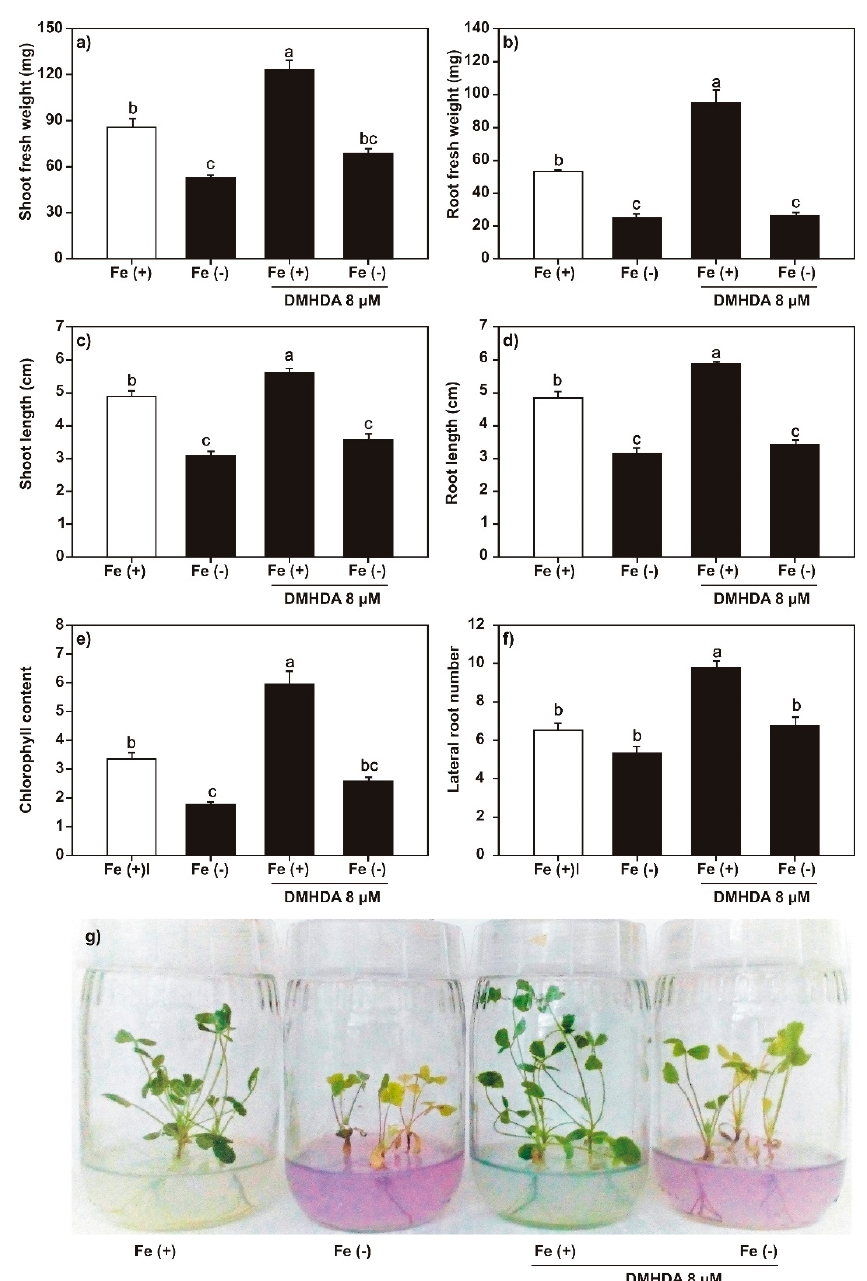
Figure 4. Effect of N,N -dimethylhexadecylamine (DMHDA) on Medicago truncatula growth. The M. truncatula plants were cultured in MS medium with DMHDA (8 μ M) under both iron sufficiency (control) and iron deficiency for 14 days. ( a ) Shoot fresh weight; ( b ) root fresh weight; ( c ) shoot length; ( d ) root length; ( e ) chlorophyll content; and ( f ) lateral root number. Panel ( g ) shows the phenotypes of plants in the treatments. Different lowercase letters above the standard error bars indicate significant differences between treatment calculated with two-way ANOVA and Tukey’s test ( p < 0.5; n = 9).